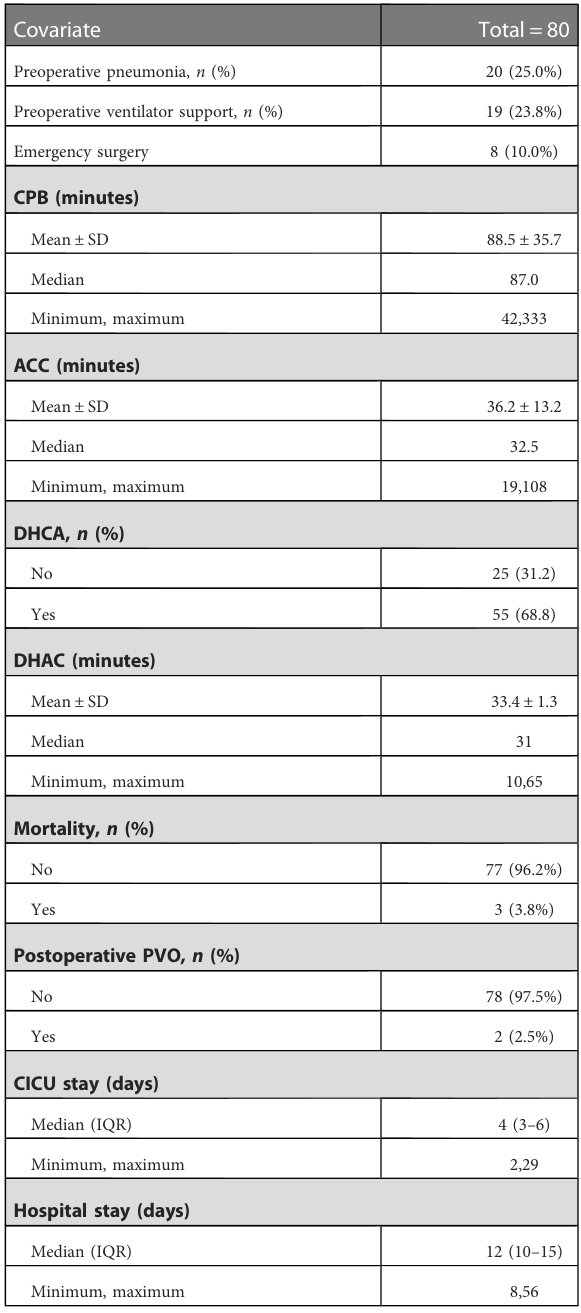
TABLE 2 In-hospital and follow-up